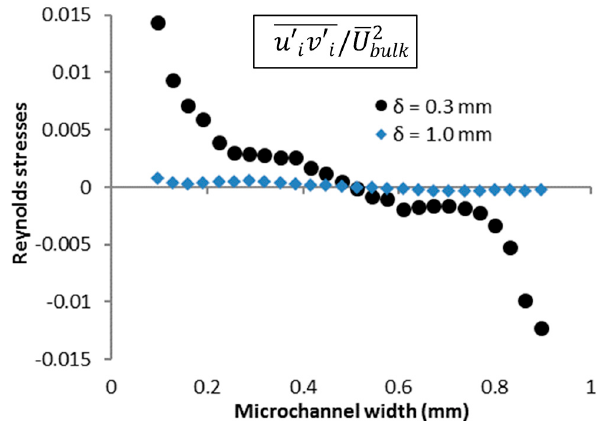
Figure 9. Normalized Reynolds stresses at 20 mL/h across the channel at δ = 0.3 mm and δ = 1.0 mm.